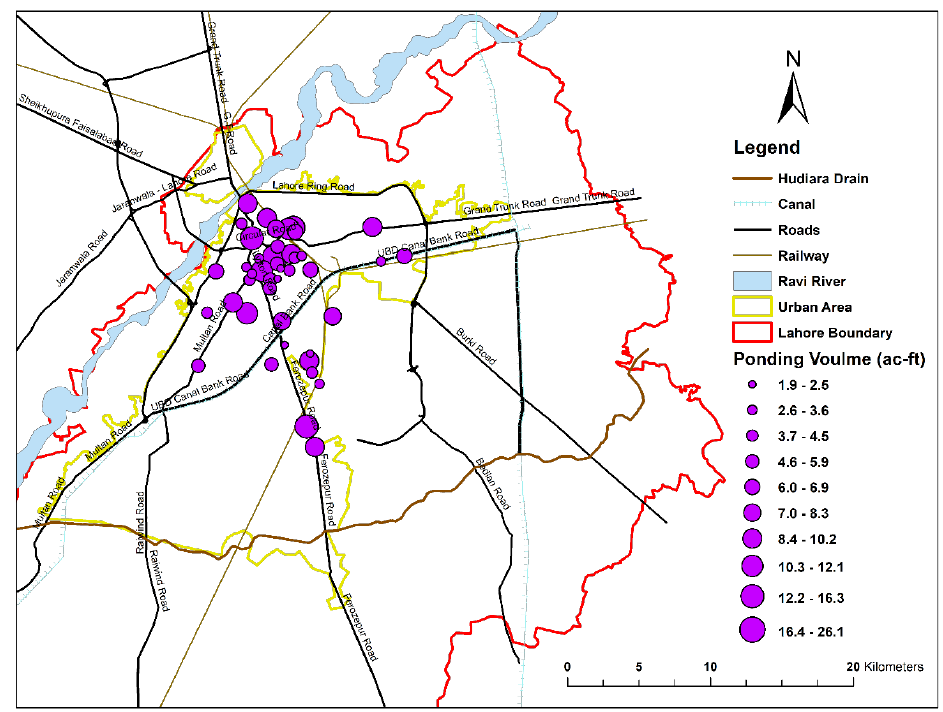
Figure 6. Rainwater harvesting potential from road runoff in the urban area of